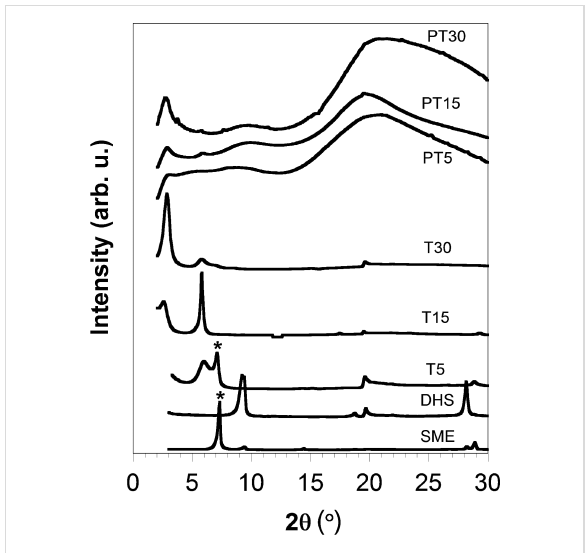
Figure 2: XRD spectra of SME, dehydrated SME (DHS), TF-interca- lated hybrids (T5, T15, and T30), and the PS/TF–intercalated SME materials (PT5, PT15 and